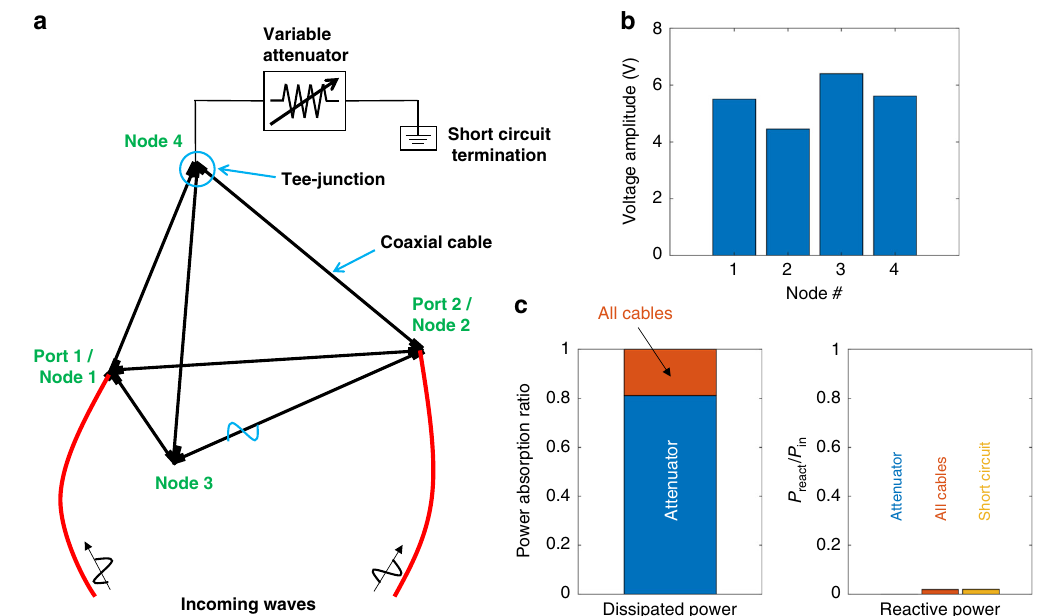
Fig. 4 Voltage pro fi le and power distribution of CPA state in idealized simulation. a Schematic of the microwave graph with labeled ports under CPA condition at 2.2999 GHz in simulation. b Voltage pro fi les of four nodes in the graph under CPA condition. c Power distribution among the graph components under the CPA condition. Left plot shows that about 80% of the power are being dissipated on the attenuator, while the remainder is dissipated in the uniformly attenuated cables. Right plot shows reactive power on the cables and short circuit. Compare with the "Anti-CPA" condition in Supplementary Fig. 2.